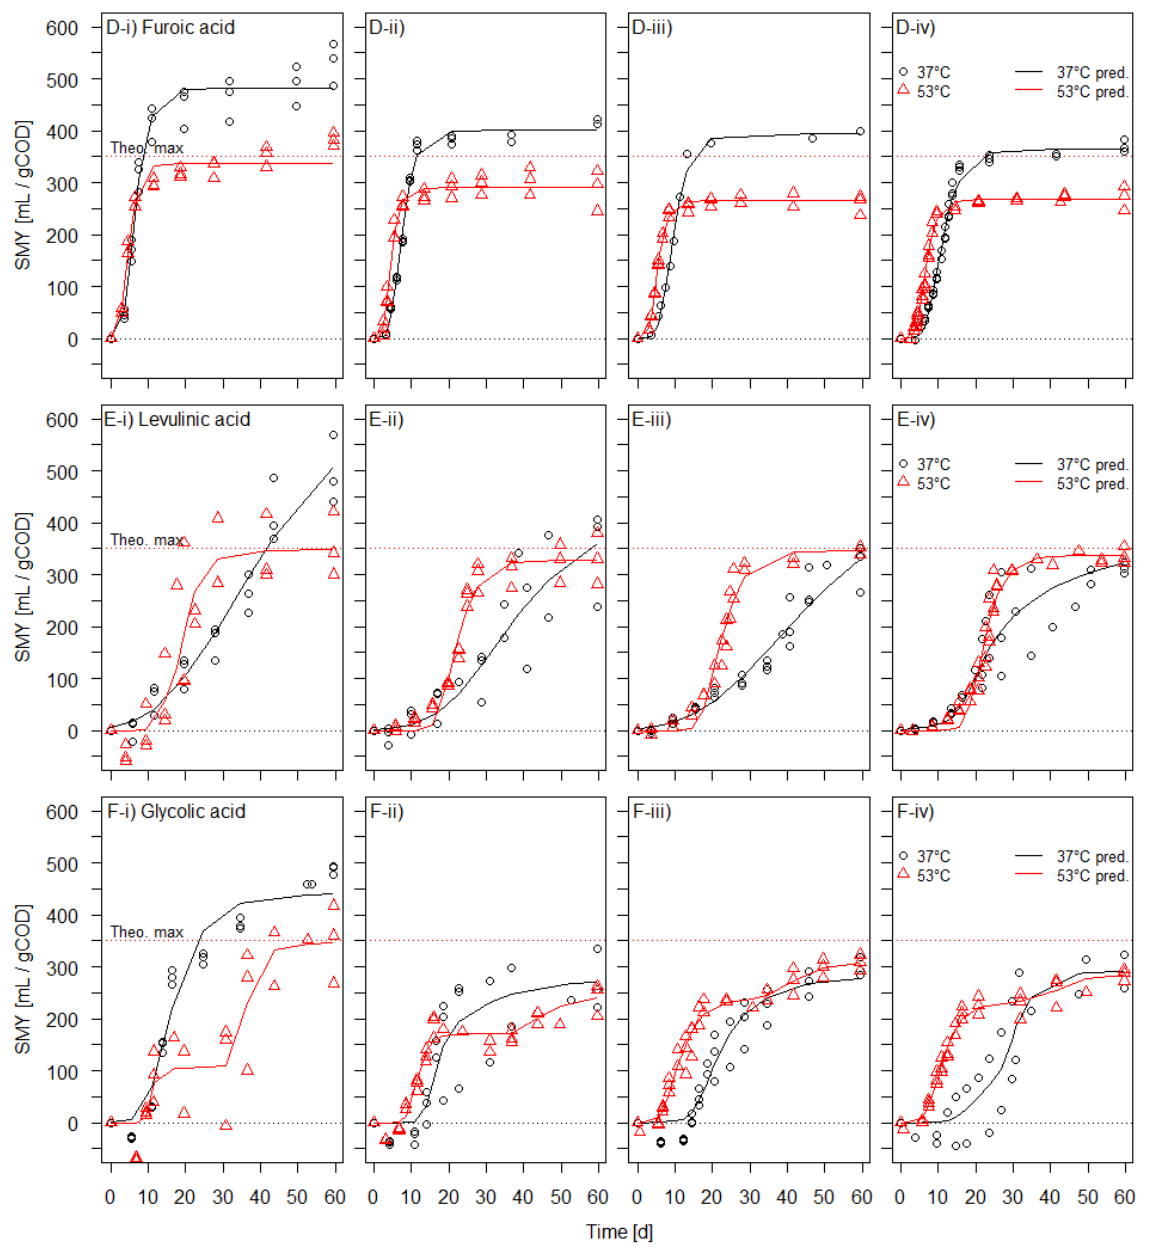
Figure 4. Measured specific methane yields for ( D ) furoic acid, ( E ) levulinic acid, and ( F ) glycolic acid from their per batch-test added amounts of ( i ) 0.1 gCOD, ( ii ) 0.2 gCOD, ( iii ) 0.3 gCOD, and ( iv ) 0.4 gCOD under mesophilic and thermophilic conditions, along with the fitted modified Gompertz functions (n = 3 for all test concentrations of the acidic compounds at 37 °C and 53 °C, except n = 2 for 0.3 gCOD levulinic acid and 0.4 gCOD glycolic acid at 53 °C and 37 °C, respectively. n = 1 for 0.3 gCOD furoic acid at 37 °C).